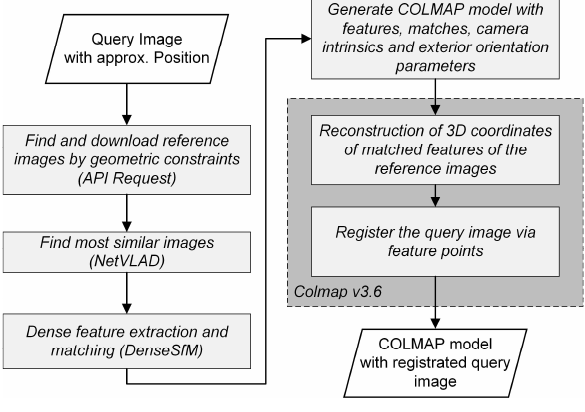
Figure 1. Our processing